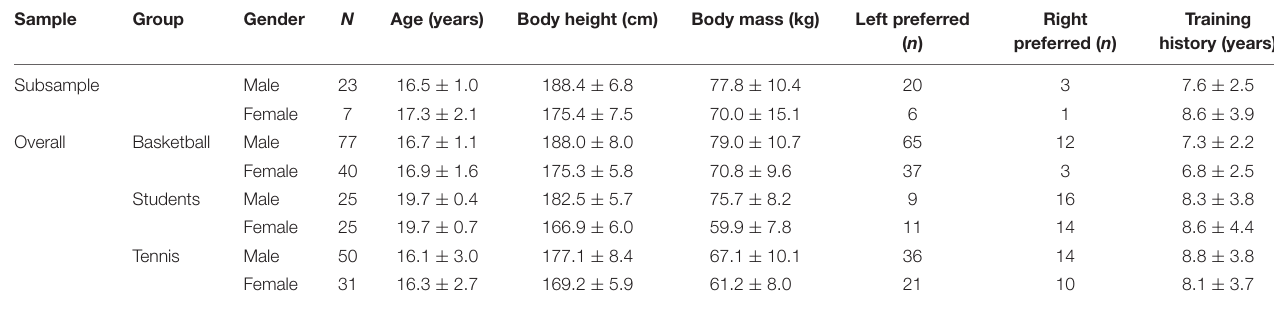
TABLE 1 | Characteristics of the participants in the subsample and overall group.